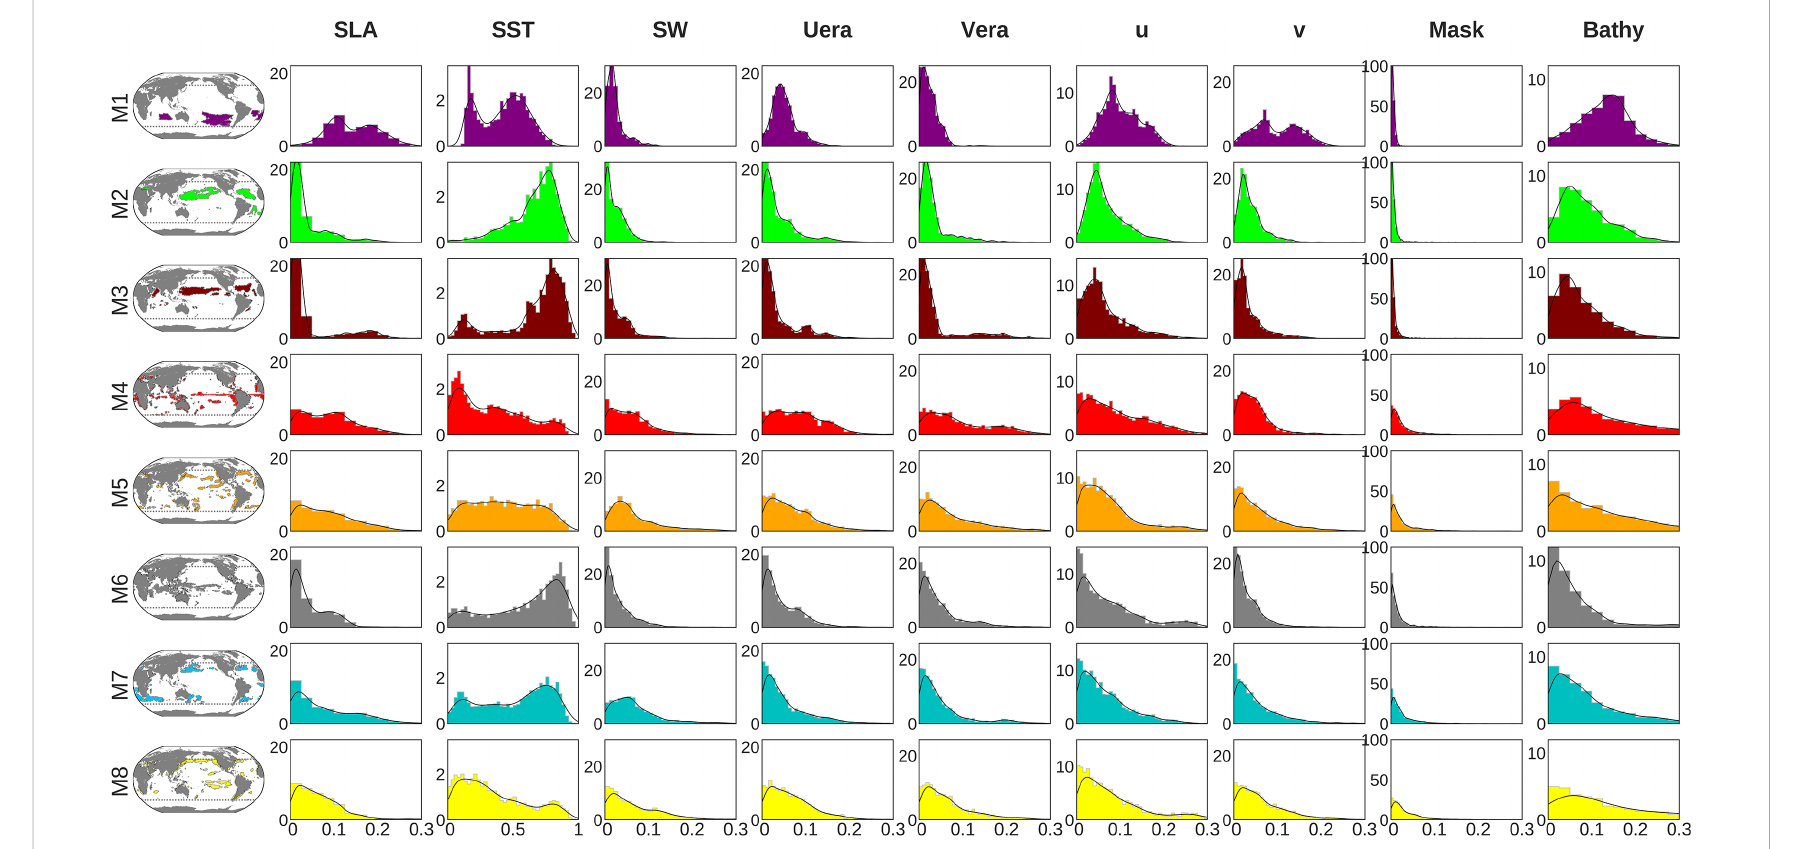
FIGURE 9 Normalized distribution (y-axis) of the relative importance of each predictor (x-axis) computed over the percentile-90 area for each mode. NB: the scale on the x-axis is homogeneous across all the variables but